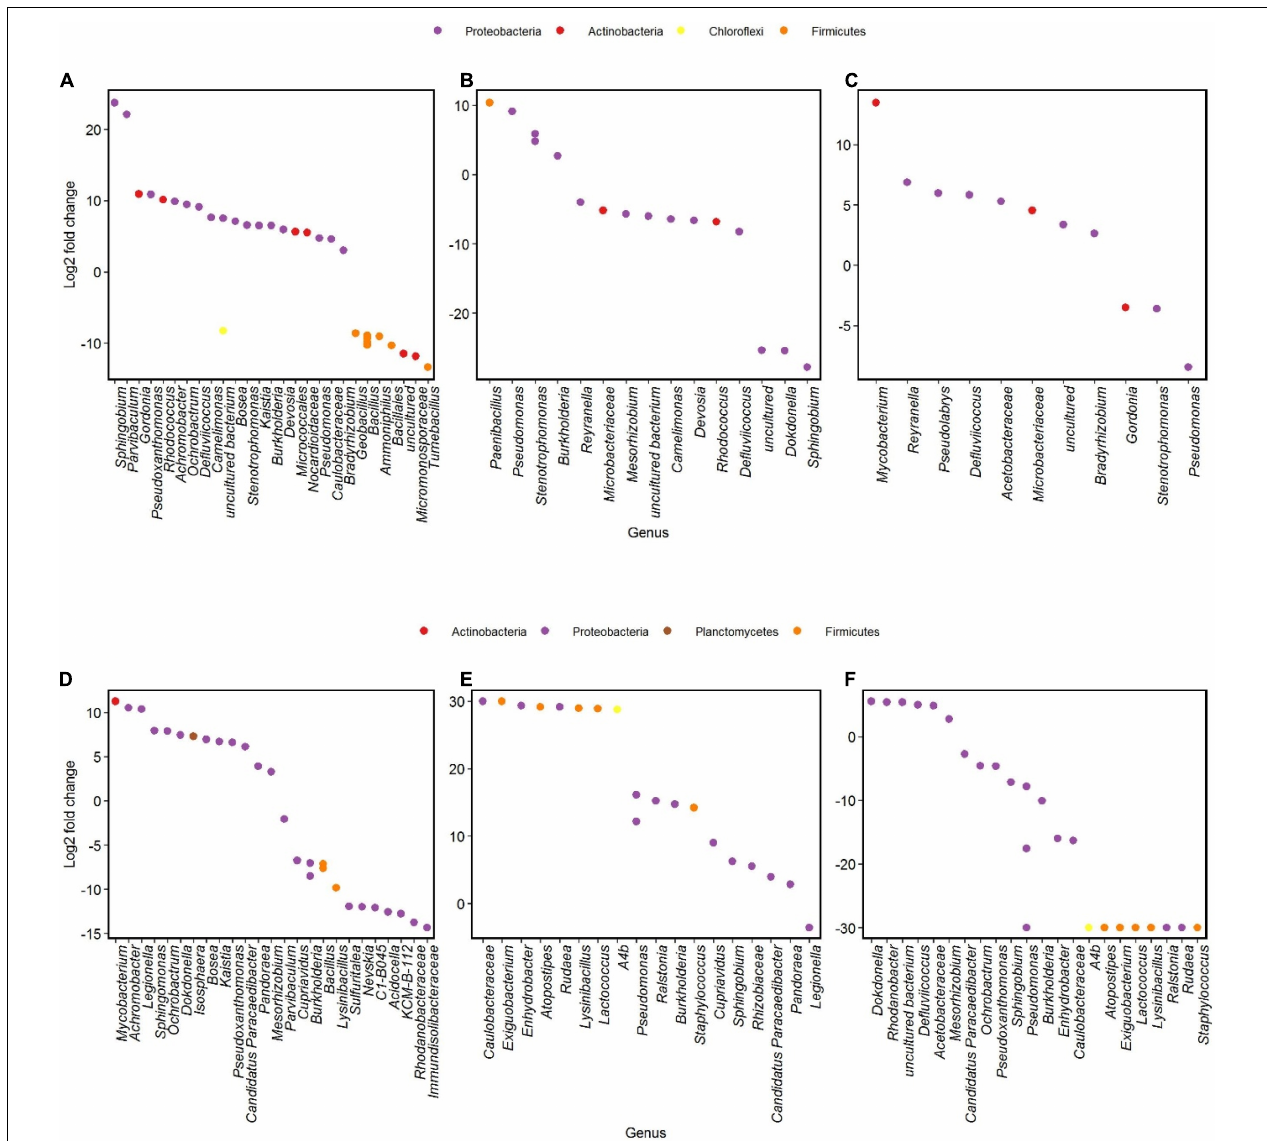
FIGURE 6 | Differential analysis showing OTUs whose abundance significantly changed in time after oil exposure ( p < 0.01). Log 2 -fold change is the log ratio of observed differences in abundance between two different time points. Genera with Log 2 -fold changes > 0 and < 0 increased and decreased in abundances, respectively. Communities U1 and P1 between days 1 and 120 (A,D) , communities U2 and P2 between experimental days 120 and 136 (B,E ; day 120 of incubation 1 and day 16 of incubation 2, respectively), and communities U2-FP and P2-FP between experimental days 136 and 180 (C,F ; days 16 and 60 of incubation 2,